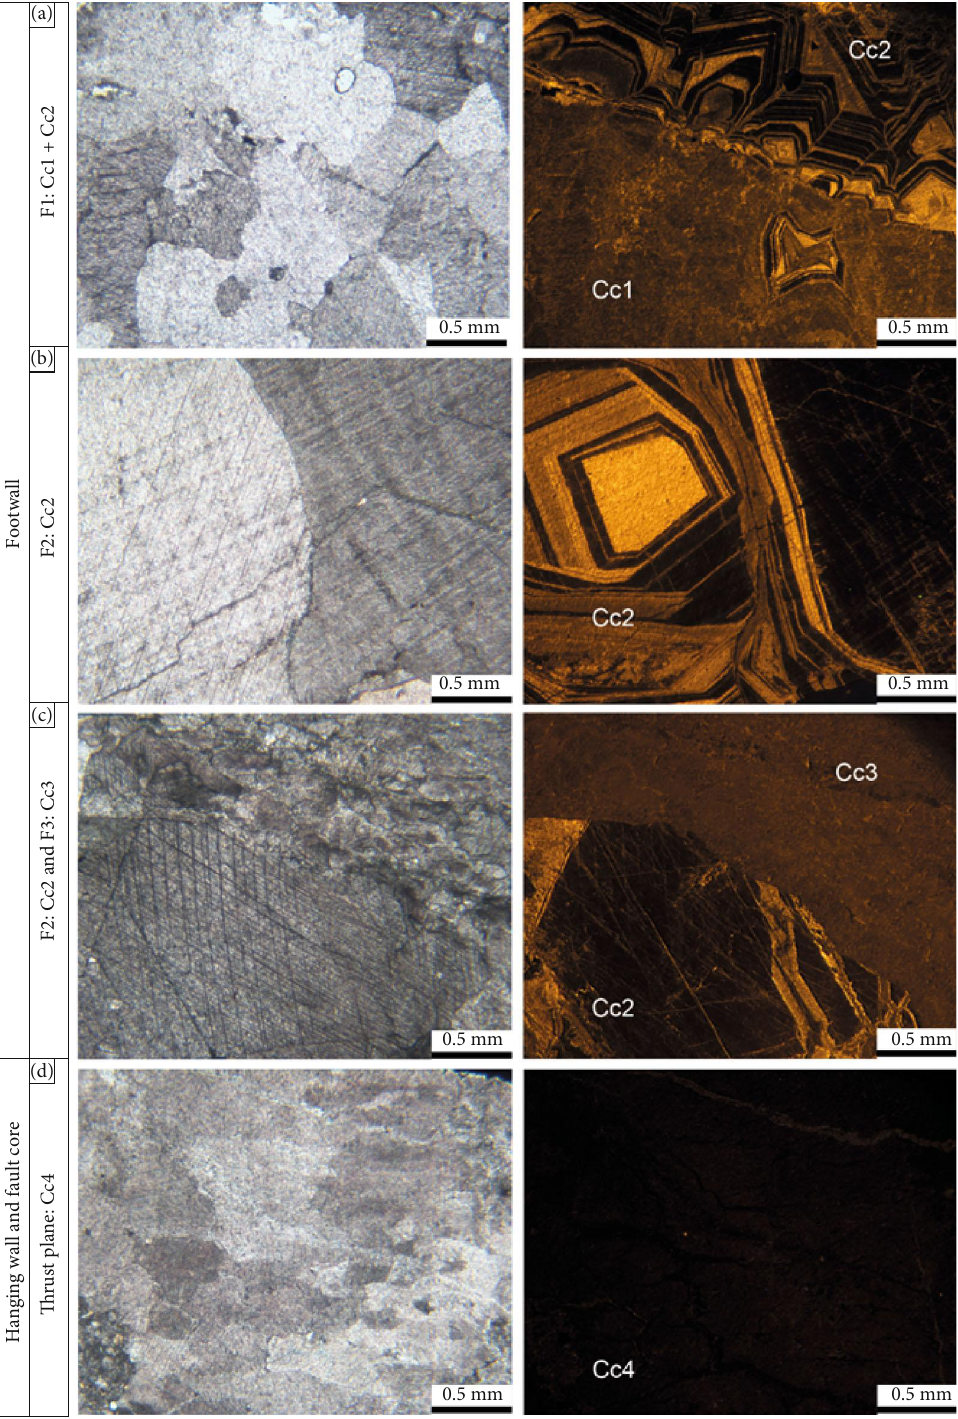
Figure 8: Paired optical and CL microphotographs from calcite cements precipitated within the fault core and fault damage zone of the studied thrust. (a) Fracture F1 cemented by calcite cements Cc1 and Cc2. (b) Calcite cement Cc2, with its characteristic CL zonation, fi lling a fracture F2. (c) Cc3 fi lling a F3 fracture, postdating a fracture F2 fi lled with Cc2. (d) Cc4 in the main fault